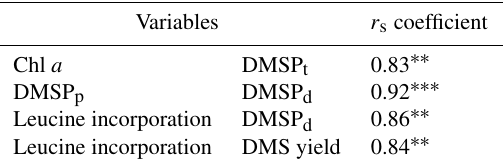
Table 2. Spearman’s rank correlation coefficients ( r s ) for various variables measured during